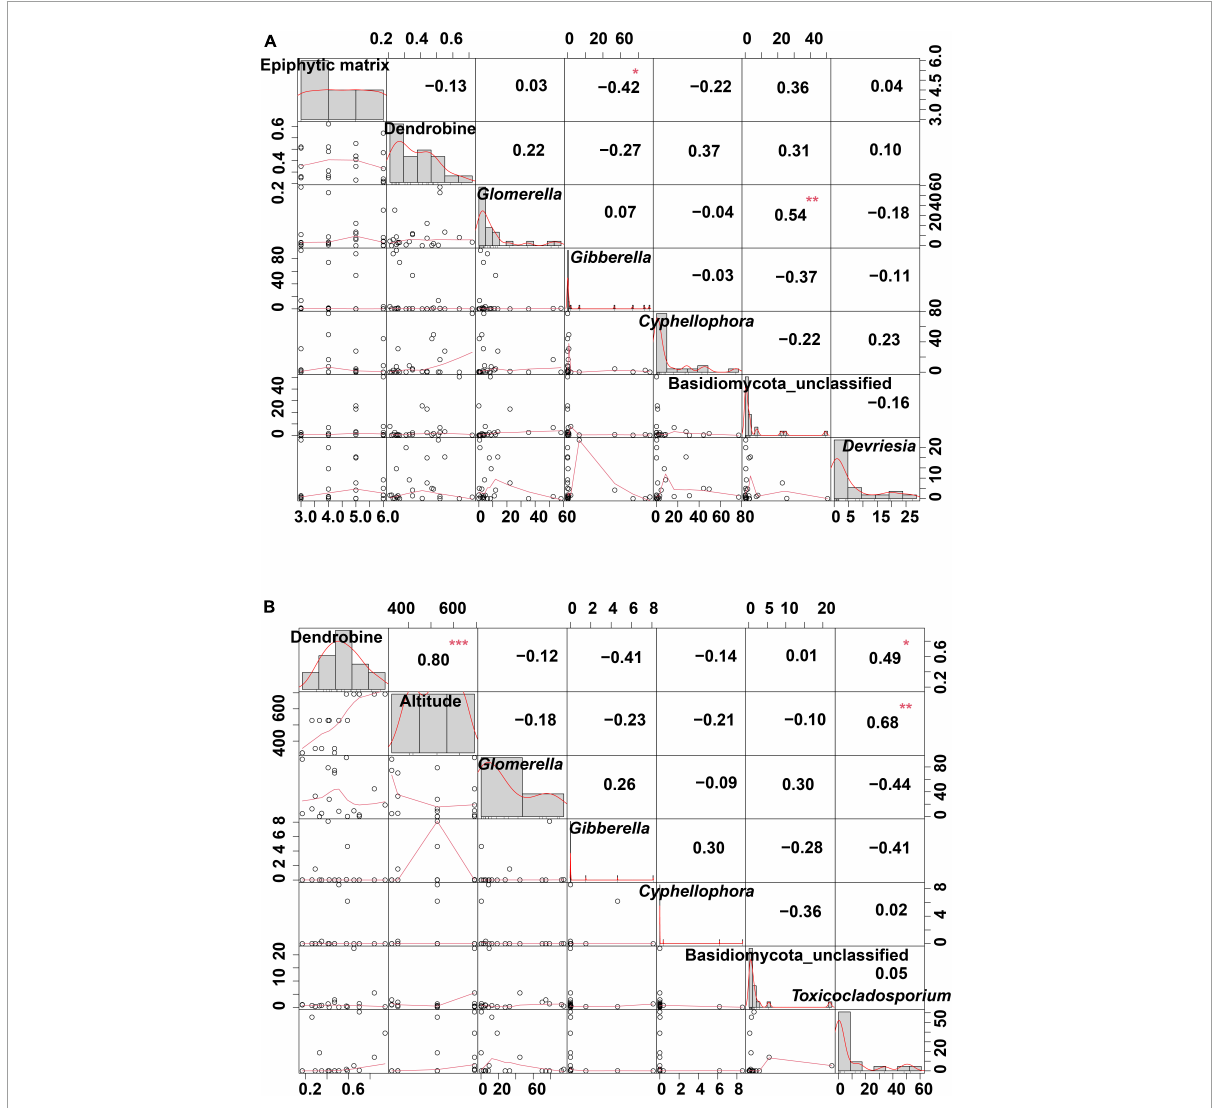
FIGURE6 Correlation analysis of habitat factors and dendrobine content in Dendrobium nobile . (A) Correlation analysis among the dendrobine content, epiphytic matrix, and relative abundance of endophytic fungi in HN samples. (B) Correlation analysis among the dendrobine content, altitude, and relative abundance of endophytic fungi in D. nobile from GZ production area. *0.01 < P < 0.05; **0.001 < P < 0.01; and *** P <